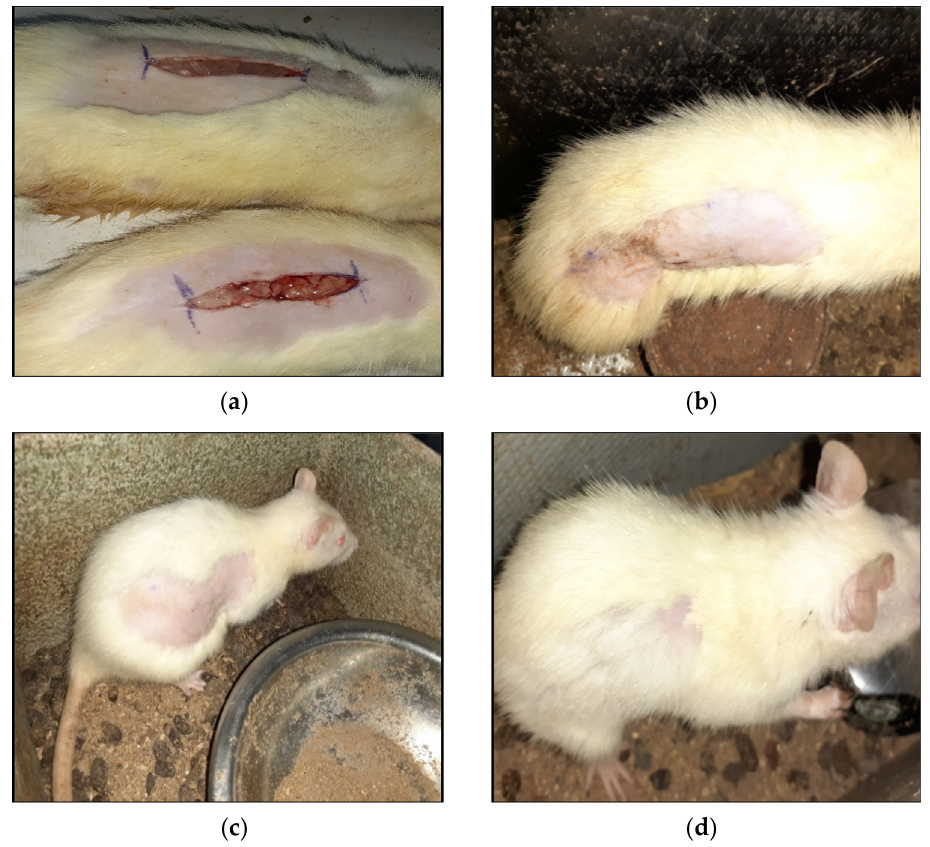
Figure 3. ( a ) Day 0 animal incision wound. Incision length = 4 cm, ( b ) day 9 scar formation, ( c , d ) gross appearance after wound closure and scar formation on the healed area using 3% hydrogel. Note: average rat body length (nose tip to tail base) = 19 cm.